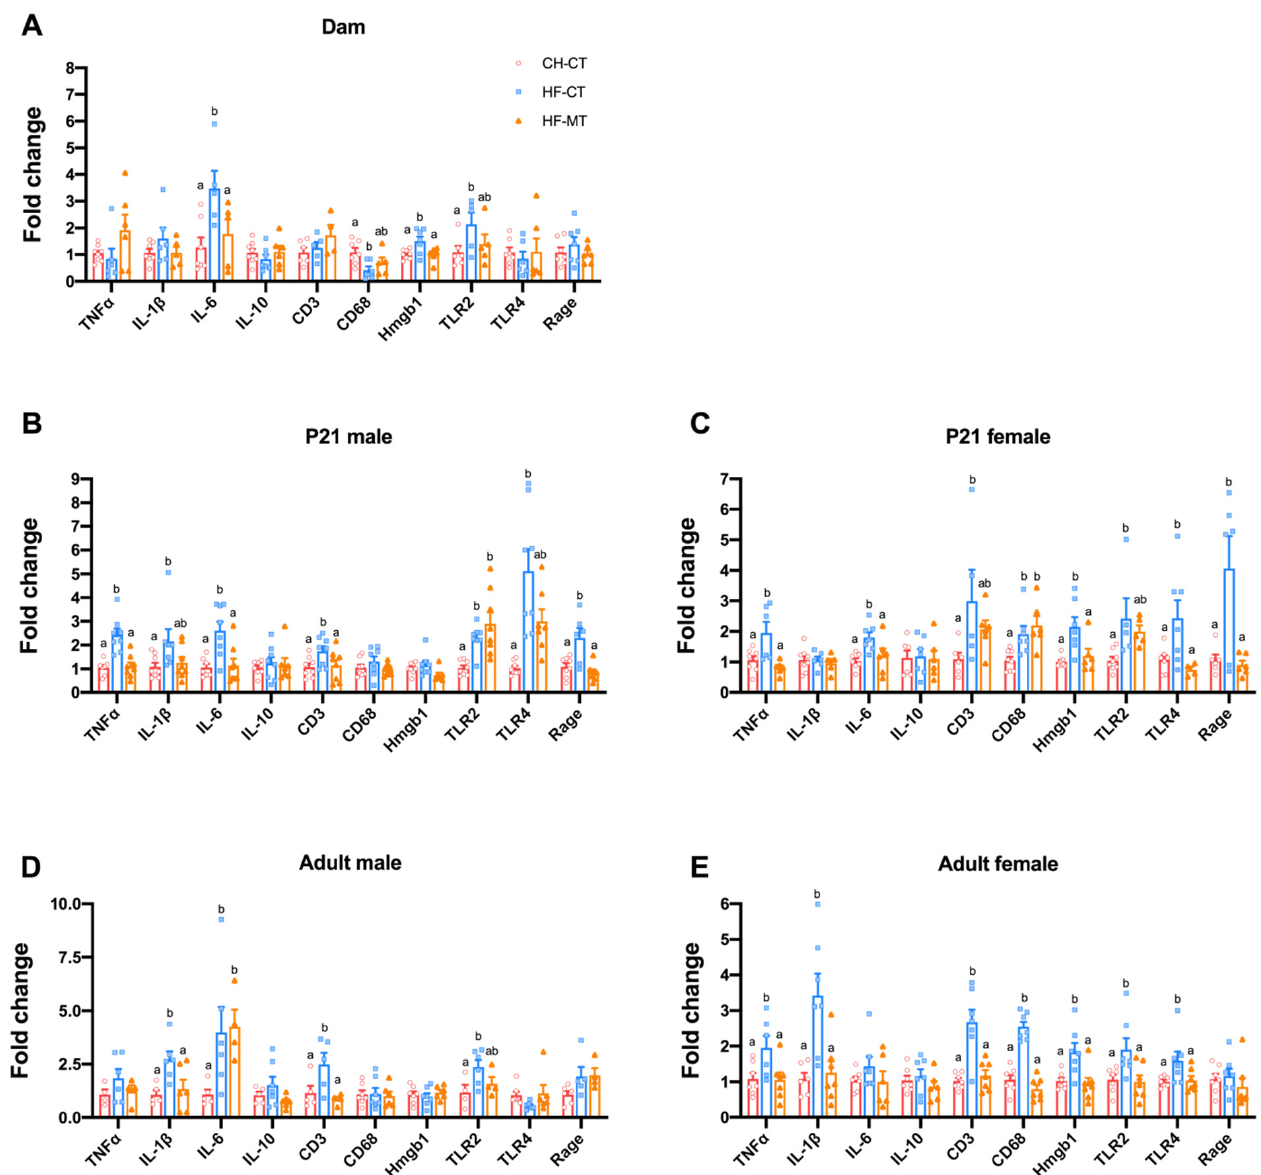
Figure 4. Maternal metformin treatment attenuates maternal high-fat diet induced gut inflamma- tion in dams and offspring: ( A ) colonic mRNA expression of inflammatory markers including tumor necrosis factor alpha (TNF α ), interleukin 1 beta (IL-1 β ), interleukin 6 (IL-6), interleukin 10 (IL ‐ 10), CD3, CD68, toll ‐ like receptor 2 (TLR2), toll ‐ like receptor 4 (TLR4), high mobility group protein